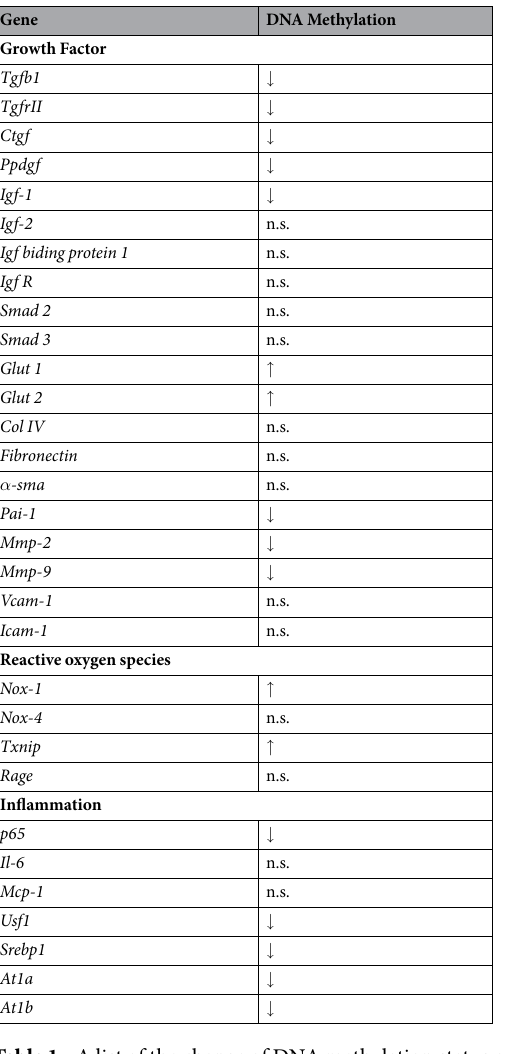
( α -8 integrin/ITGA8, a mesangial cell marker) 33 and negative staining for podocin (a podocyte marker), S100A4 (a fibroblast marker) and Na-K-ATPase (a tubular cell maker) (Fig. 2C). In addition to the ITGA8-positive stain, the histological characteristics of the cells after primary culture included an irregular shape and flattened-cylin-